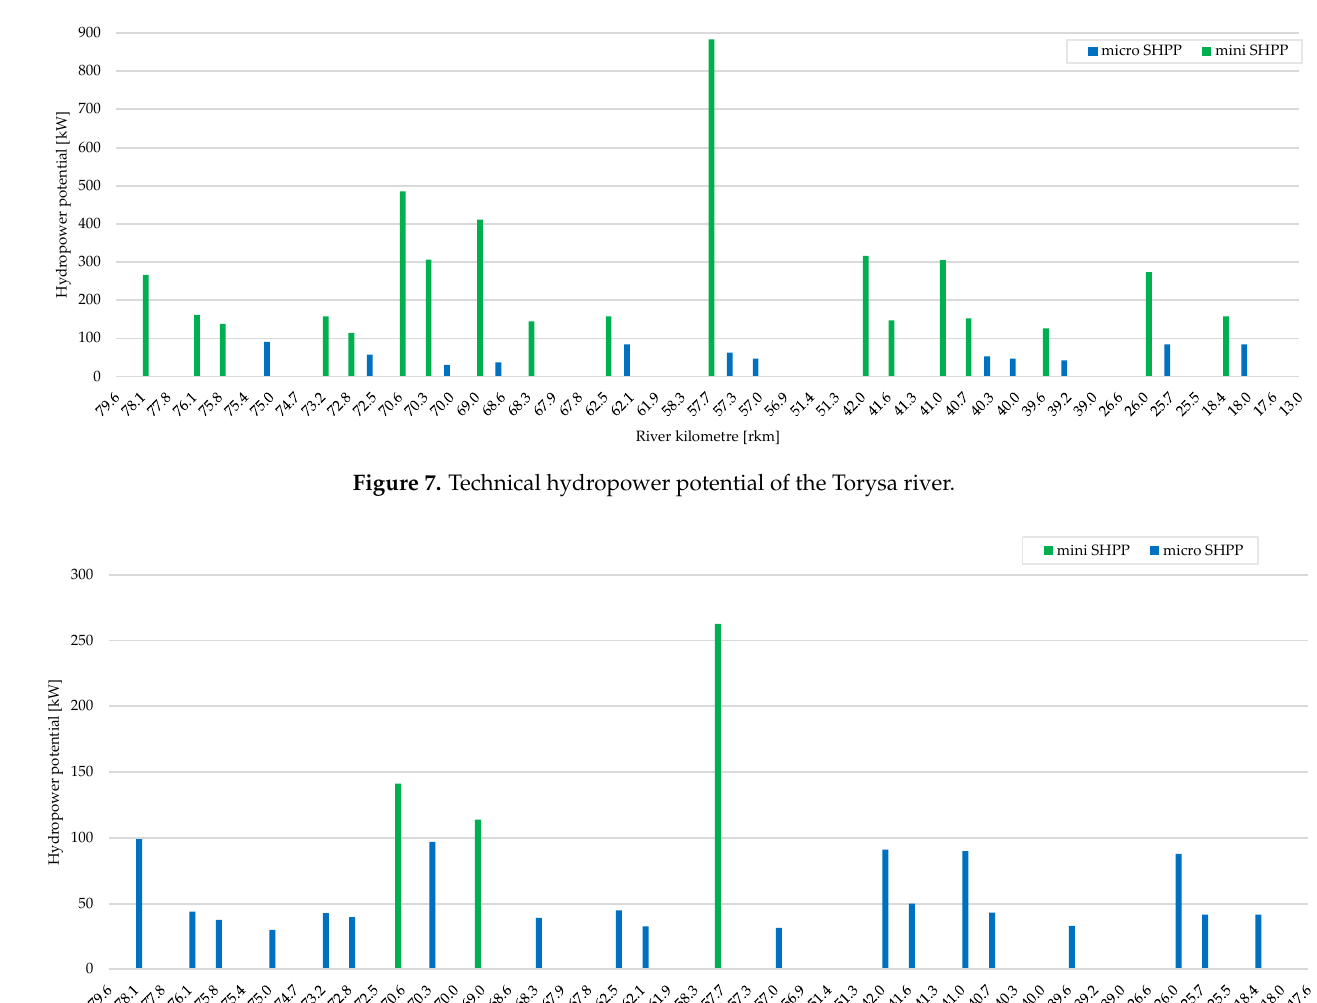
Figure 6. Gross (theoretical) hydropower potential of the Torysa river.